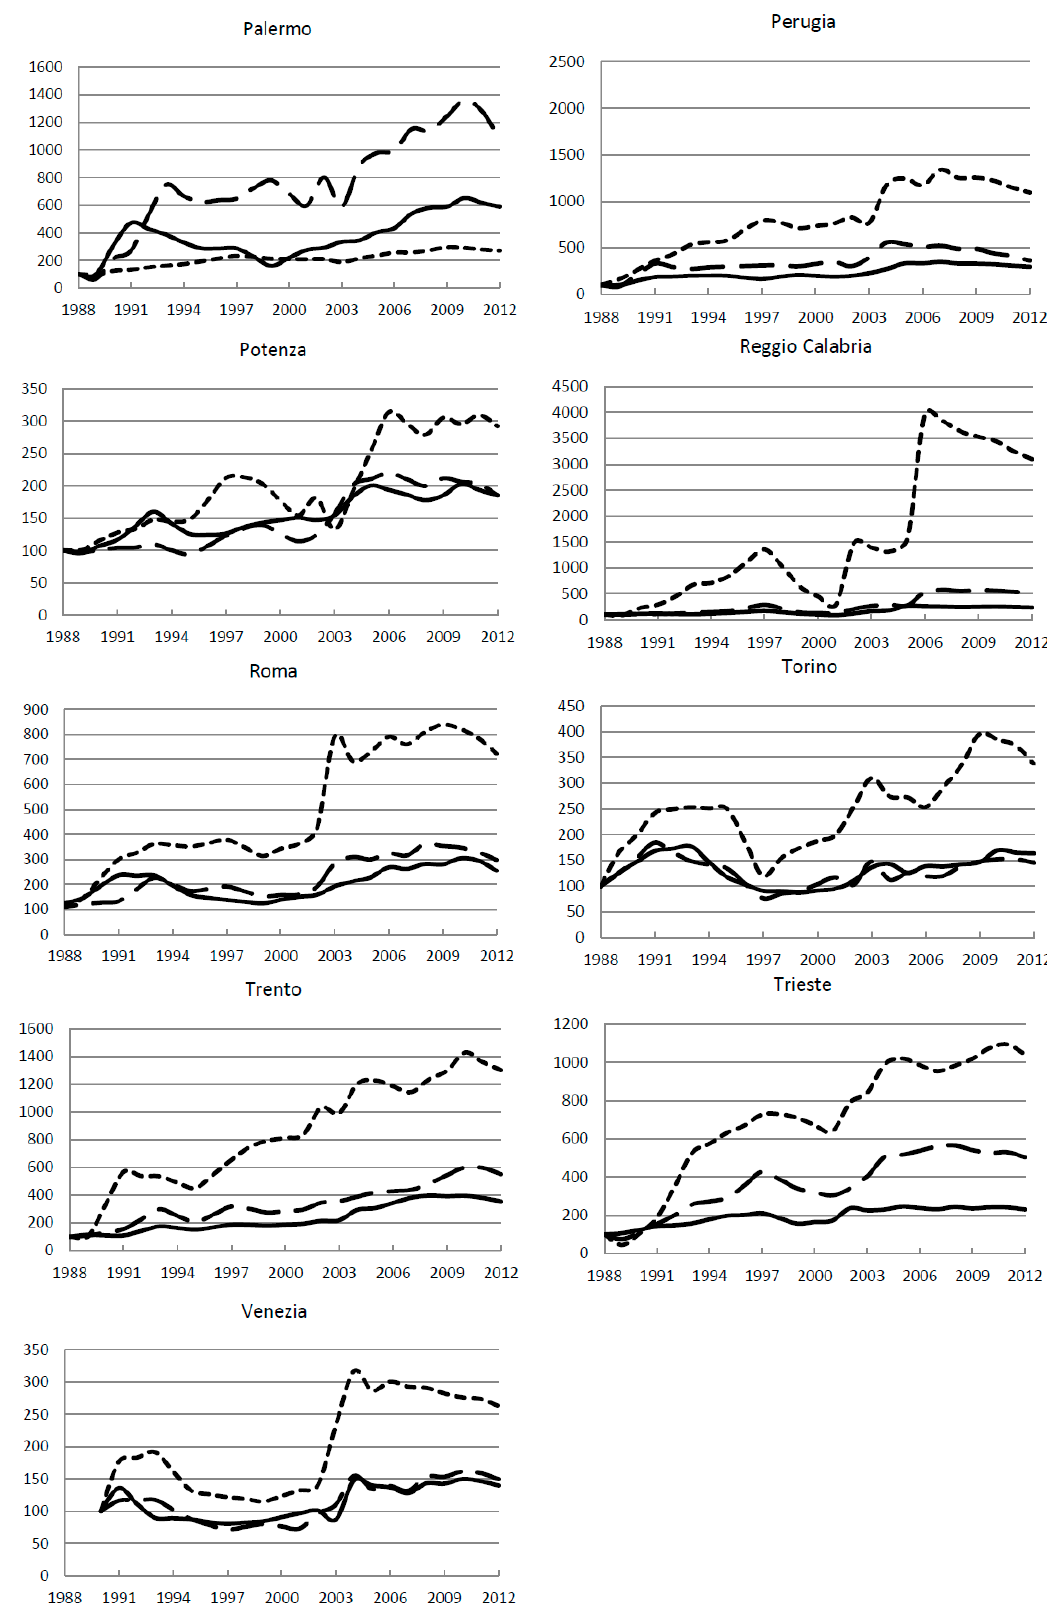
Figure A2. The trend of indexed values of urban land from 1988 to 2012 in the regional Italian capital cities and for different urban areas.